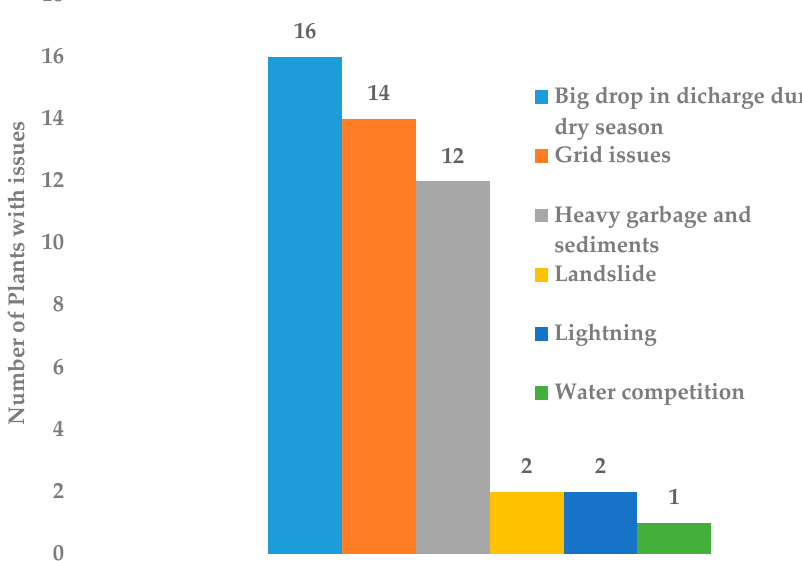
Figure 2. Interview results on factors outside operator’s control. Figure 2 reports the answers to the question: Did you have any problems with the plant or the grid caused by factors that you/the operator could not control? Respondents could give multiple answers and follow-up questions were also asked to ensure a wider set of factors were considered.